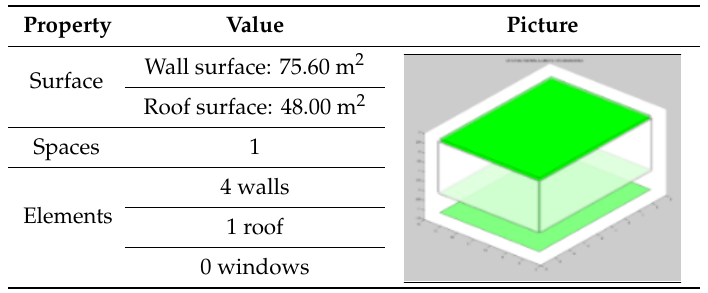
Table 8. List of scenarios generated for the